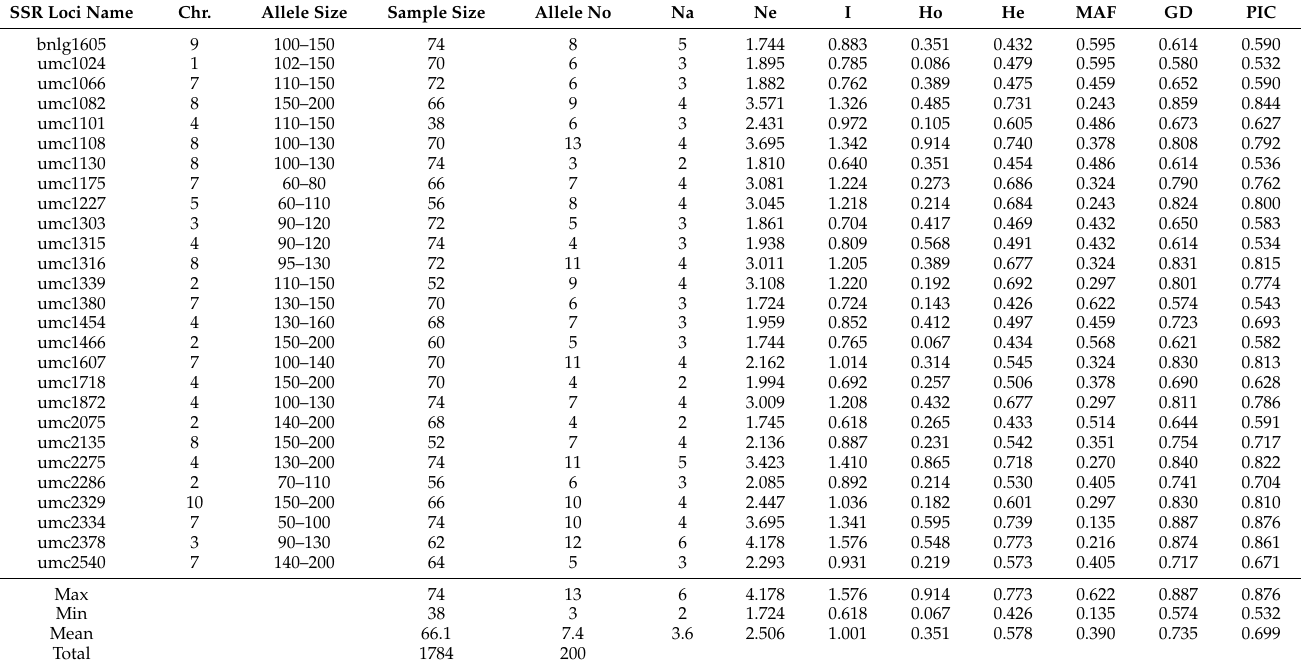
Table 2. Genetic parameters summary of 27 SSR markers used for analyzing the 37 maize landrace